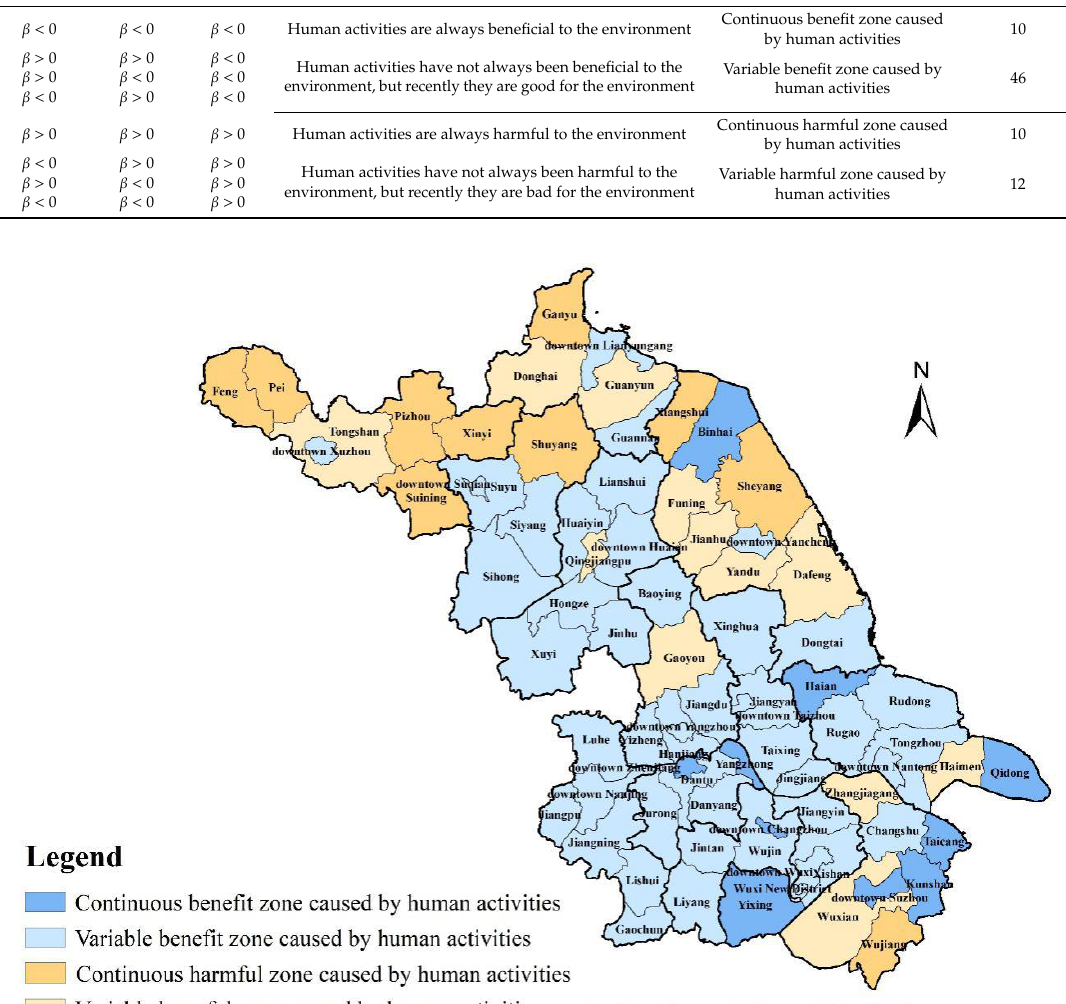
Table 5. Classification method according to the relationship between LVI and LHAI.